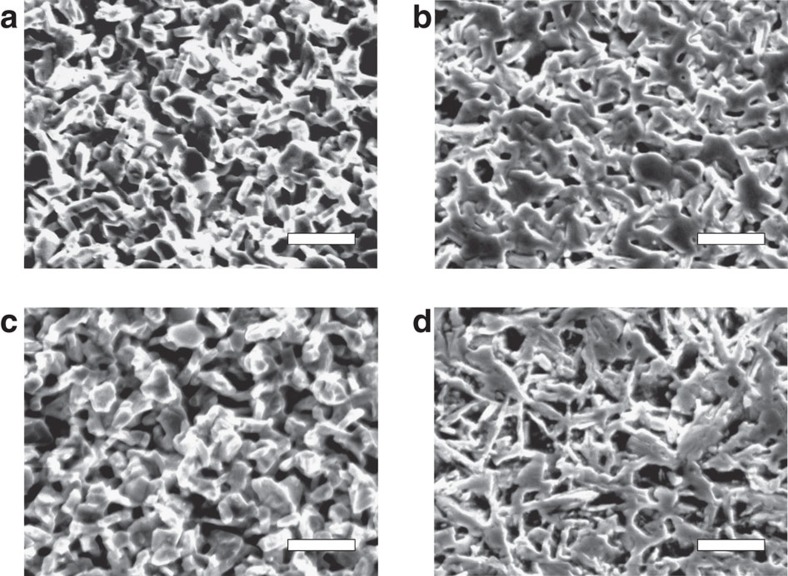
Microscopic images by scanning electron microscopy.(a) Reduced Ca2RuO3.74 (#1), (b) oxidized Ca2RuO4.03 (#2), (c) re-reduced Ca2RuO3.69 (#3) and (d) reduced Ca2Ru0.92Fe0.08O3.82. The morphology is apparently reversible in successive heat treatment: #1→#2→#3. Scale bars, 20 μm.